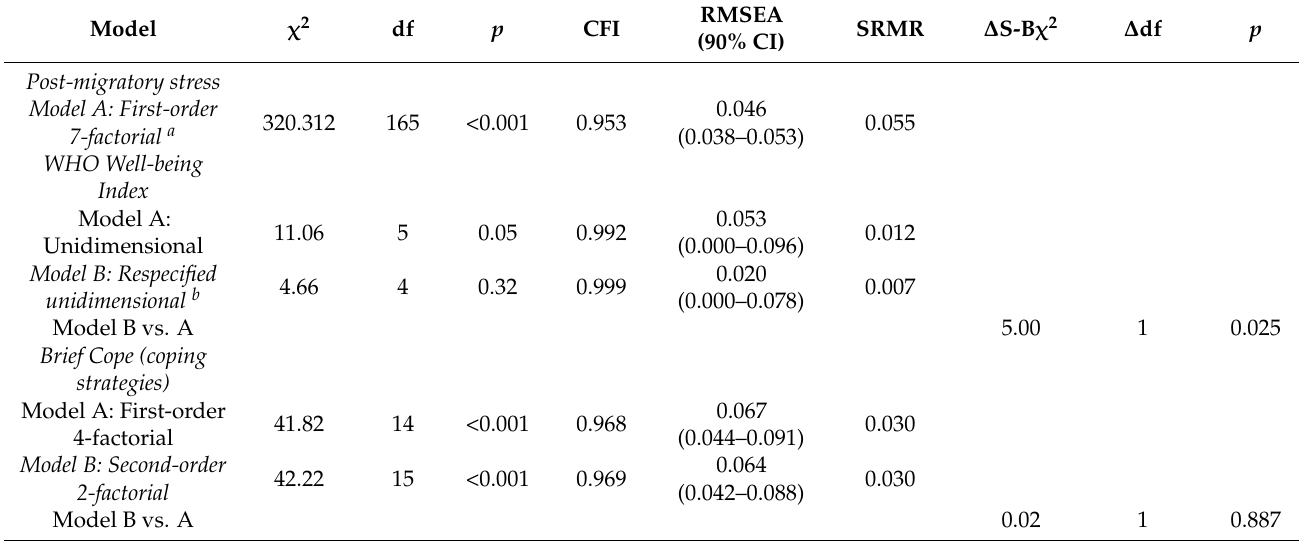
Table 2. Fit indices of measurement